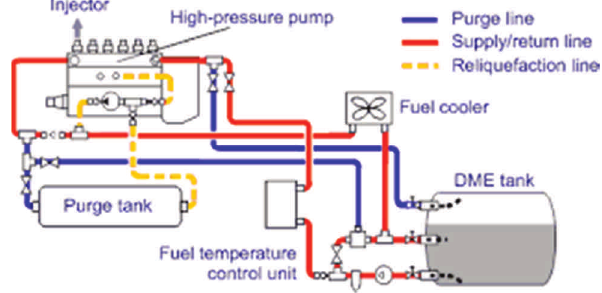
Fig. 5. Example of DME handling fuel system for small vessel